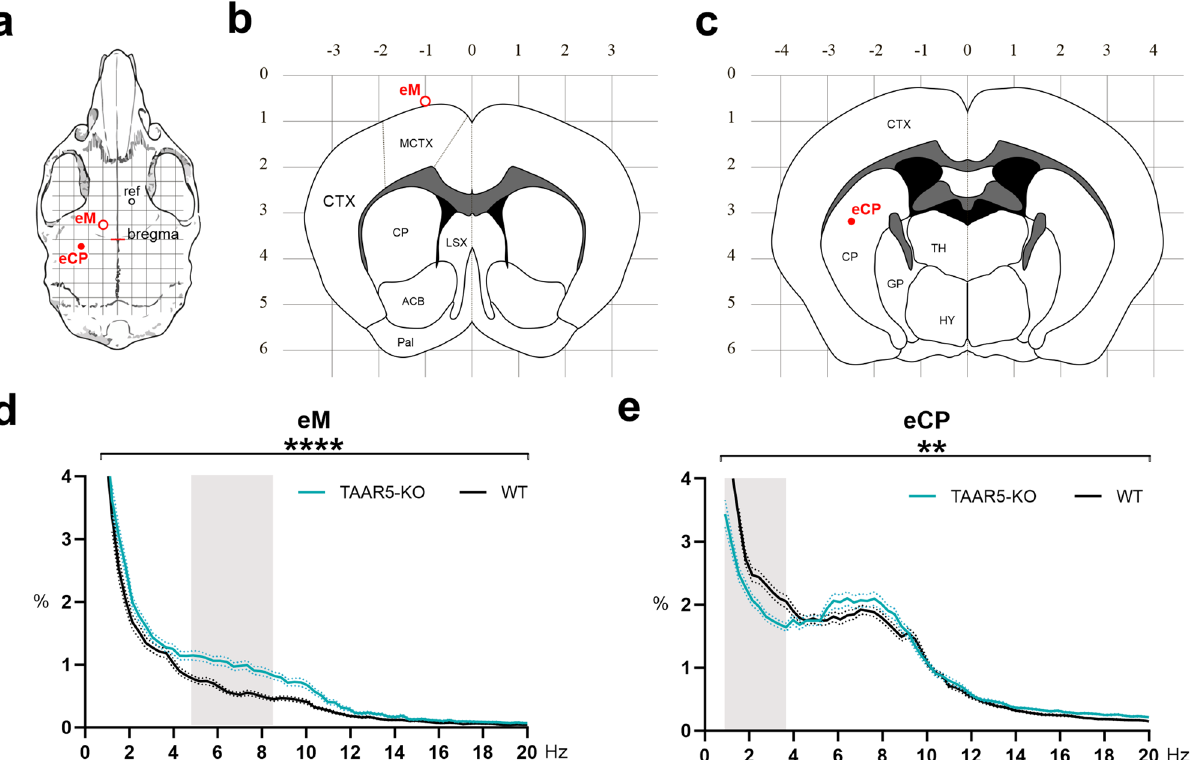
Figure 5. ECoG and striatal LFP. ( a ) Visualization of electrode placement on the skull. Grid 1 mm. ( b , c ) Visualization of eM (AP + 1; ML − 1) and eCP (AP − 0.5; ML + 2.5) electrode placements on sagittal slice 1.44 mm lateral to bregma (modified from Paxinos and Franklin the Mouse Brain in Stereotaxic Coordinates, 2001). ( d ) Power spectral density of motor cortex (eM) electrocorticogram. ( e ) Power spectral density of local field potentials in the striatum (eCP). X-axis—signal frequency in Hz; Y-axis—power spectral density in % of total density. Teal and black lines—power spectra of TAAR5-KO and WT mice, respectively; dotted lines—standard error of the mean (SEM). **P < 0.01; ****P < 0.0001 two-way ANOVA of the whole 0.9–20 Hz range. Filled grey area—significant differences in Sidak’s multiple comparisons post hoc test. eM (circle with red outline) epidural screw above motor cortex, eCP (filled red circle) intracerebral electrode in caudate-putamen, ref reference electrode (epidural screw), ACB nucleus accumbens, CP caudate-putamen, CTX cortex, GP